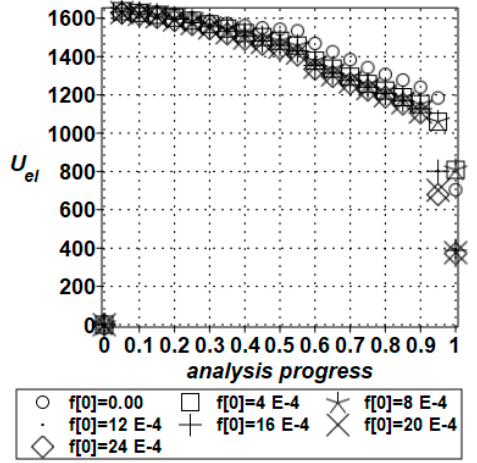
Figure 3. Elastic energy variations during deformation.